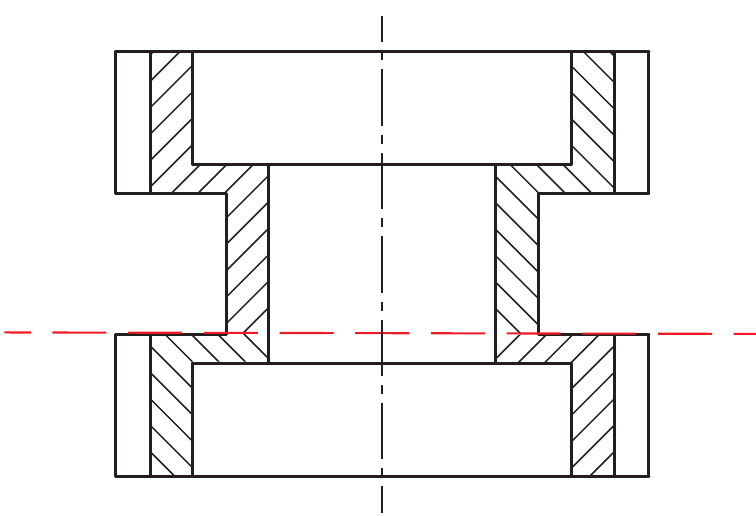
Figure 24. Section of part with inward and outside